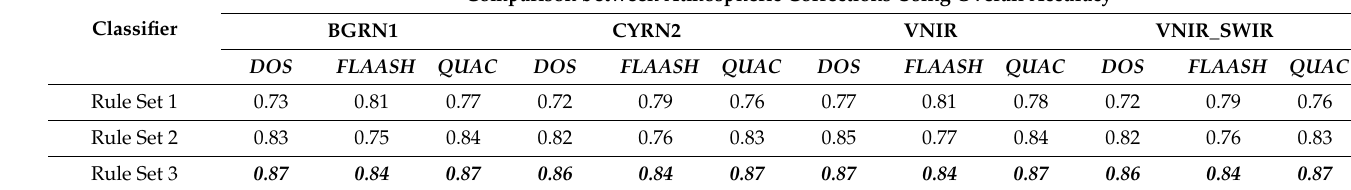
Table 10. Performance of the GEOBIA rule sets according to each atmospheric correction across all image subsets using OA as the evaluative measure. The values of the best performing classifiers are highlighted in bold and italicized.